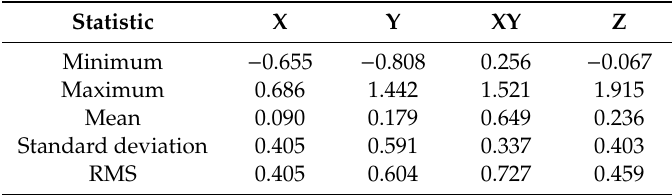
Table 2. Error of LiDAR point cloud regarding GNSS-based check points 1 .